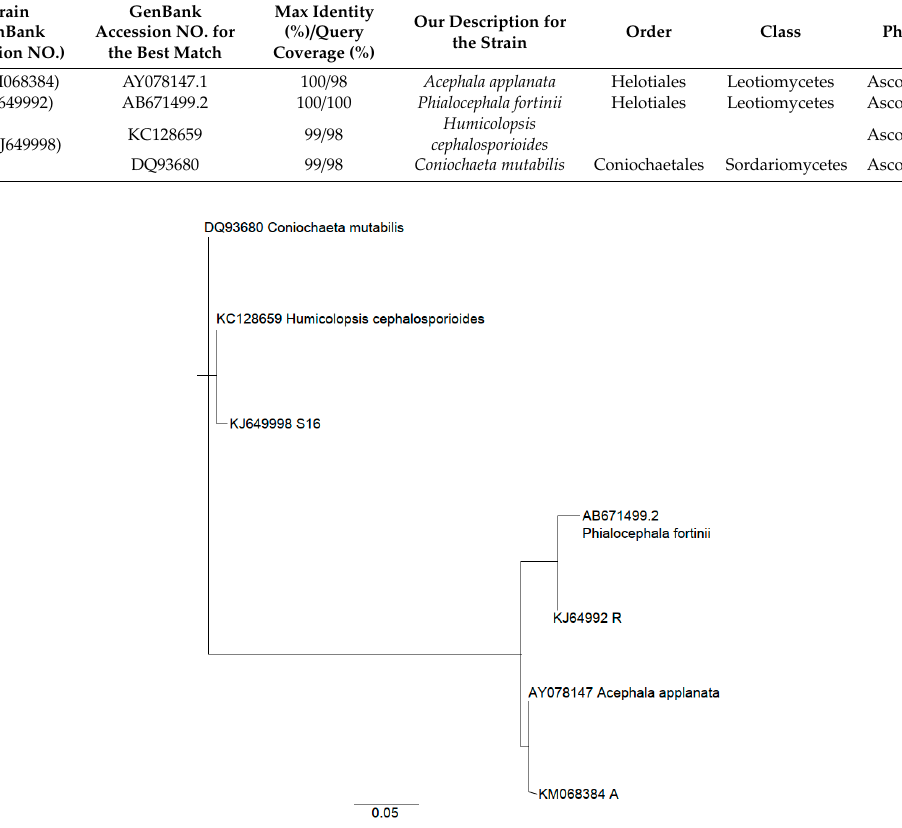
Figure 1. The Neighbor-Joining topology of ITS1, 5.8S and ITS2 rDNA sequences of root endophyte strains A, R and S16 from Scots pine and those obtained from GenBank. The phylogenetic tree was rooted with the Coniochaeta mutabilis.